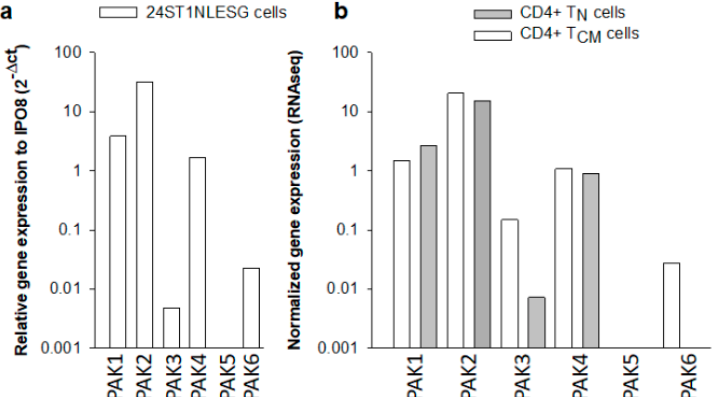
Figure 2. RNA expression levels of different PAK isoforms in 24ST1NLESG cells ( a ) and in purified naïve (T N ) and central memory (T CM ) CD4+ T cells. PAK RNA expression is reported relative to cellular IPO8 expression. Data in Figure 2a represent the mean from two independent experiments. Data in ( b ) are from a single RNAseq experiment.